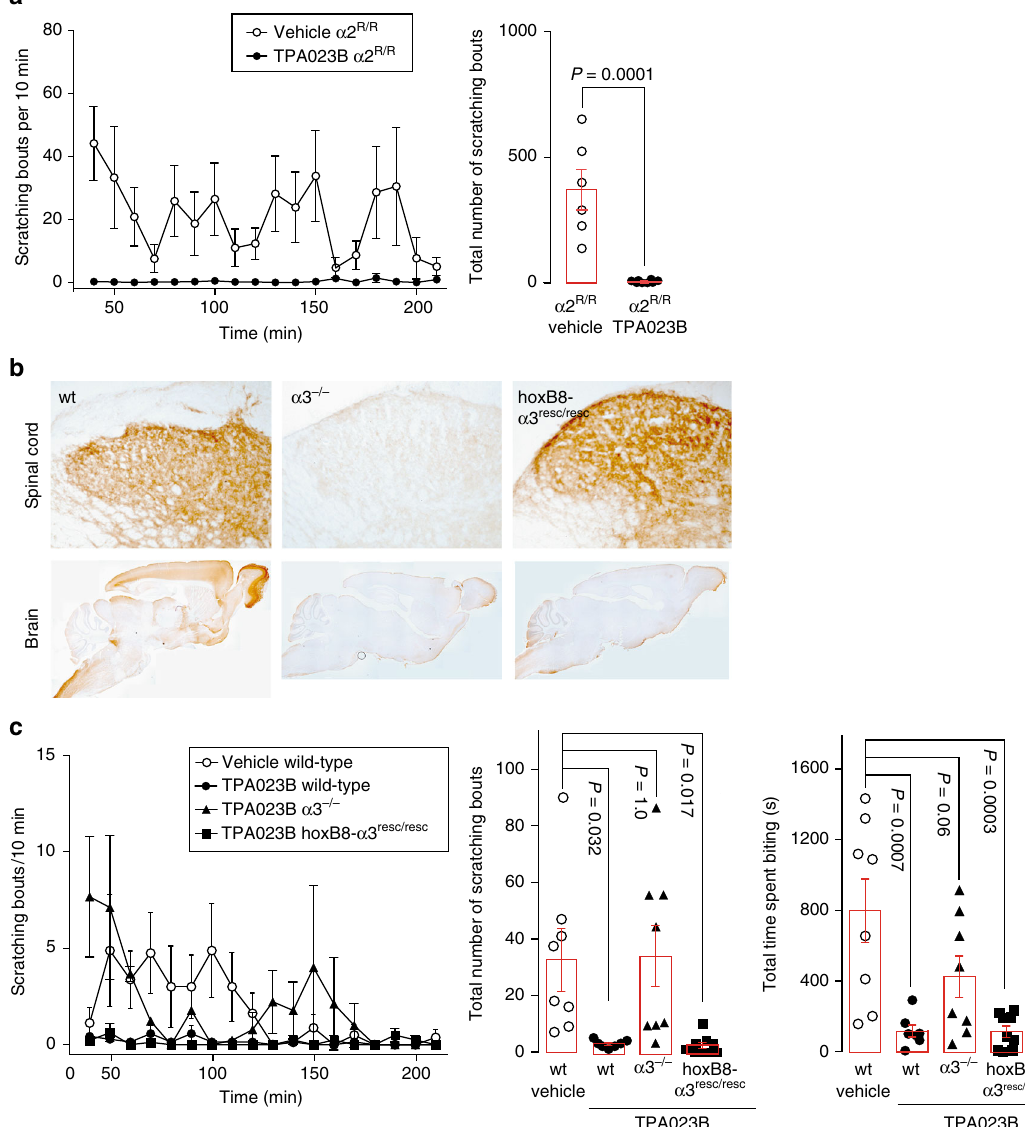
Fig. 9 Spinal α 3GABA A Rs are suf fi cient for full antipruritic ef fi cacy of TPA023B in chronic itch. a Global H → R point mutation of α 2GABA A Rs did not reduce the antipruritic effects of TPA023B (1 mg kg − 1 i.p.) in the oxazolone model of atopic-like dermatitis. Unpaired t -test, P = 0.0001, n = 6 and 8, for vehicle and TPA023B, respectively. b HoxB8-cre-mediated rescue of spinal α 3GABA A R expression in α 3GABA A R − / − mice. Immunoperoxidase staining of α 3GABA A R subunits in transverse sections of the lumbar spinal dorsal horn (top) and in sagittal brain sections (bottom). c The antipruritic action of TPA023B was fully or partially (for scratching or biting behavior, respectively) lost in global α 3GABA A R − / − mice but completely recovered in hoxB8- α 3 resc/resc mice ( P = 1.0 wt/TPA023B versus hoxB8- α 3 resc/resc /TPA023B). Note that in these experiments, dermatitis was induced at the level of the mid lumbar back to ensure that skin territories were affected that are innervated by spinal cord segments with HoxB8-cre mediated rescue. ANOVA followed by Dunnett ’ s post hoc test F(3,28) = 5.80, F(3,28) = 8.72, for scratching bouts and time spent biting, respectively. n = 8, 7, 8, 9, for wt/veh, wt/TPA023B, α 3 − / − /TPA023B, and hoxB8- α 3 resc/resc /TPA023B, respectively. Error bars indicate controlled using a PHD Ultra syringe pump with a nanomite attachment (Harvard Apparatus, Holliston, MA). The micropipette was left in place for 5min after the injection. Wounds were sutured and the animals were injected i.p. with 0.03 mgkg − 1 buprenorphine and allowed to recover on a heat mat. Rabies virus injected mice were subjected to perfusion 3 – 5 days after injection.